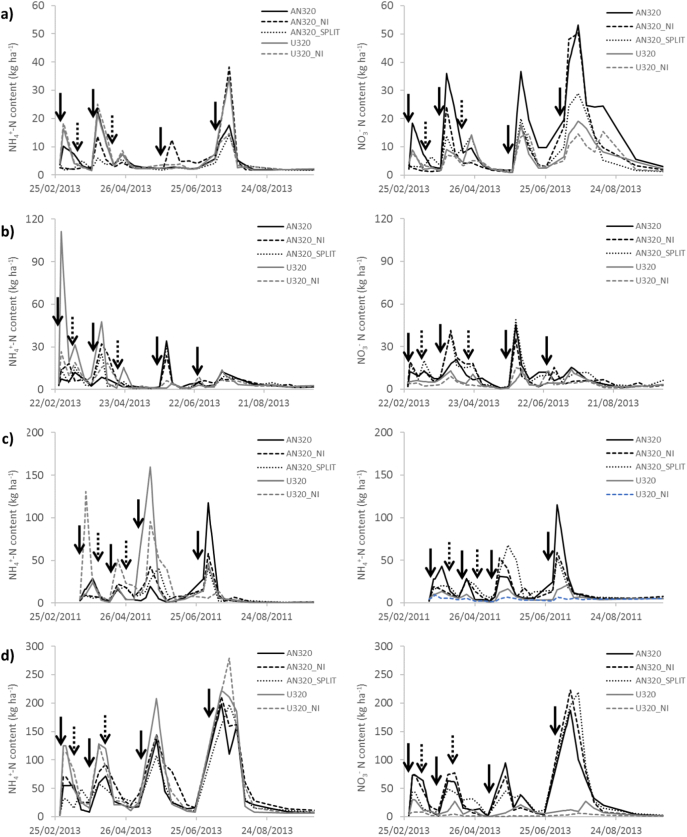
Time series of the soil mineral N concentrations (NH4+ and NO3−) for the treatments applied at 320 kg N ha−1: AN320, AN320_NI, AN320_Split, U320 and U320 + NI. Note that scales are different among sites. Data for Crichton is not presented because of missing data during the first two months of the experiment. a) Drayton, b) North Wyke, c) Hillsborough, d) Pwllpeiran.